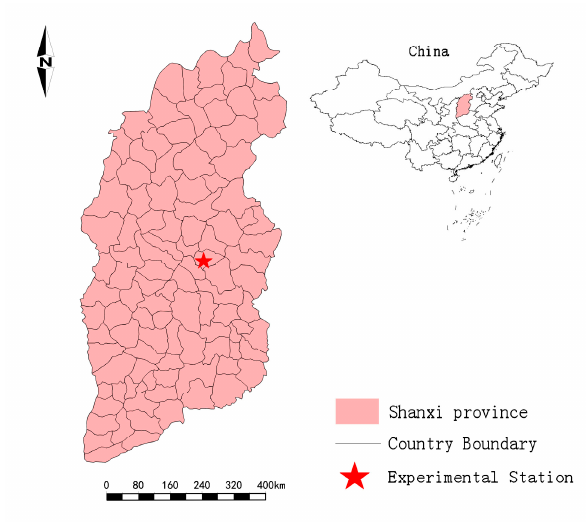
Figure 1. Area location map.